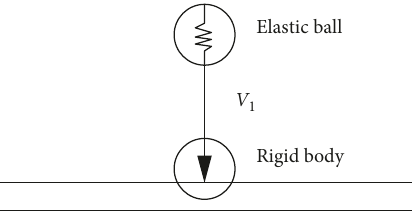
Figure 1: Elastic sphere impacting rigid surface.